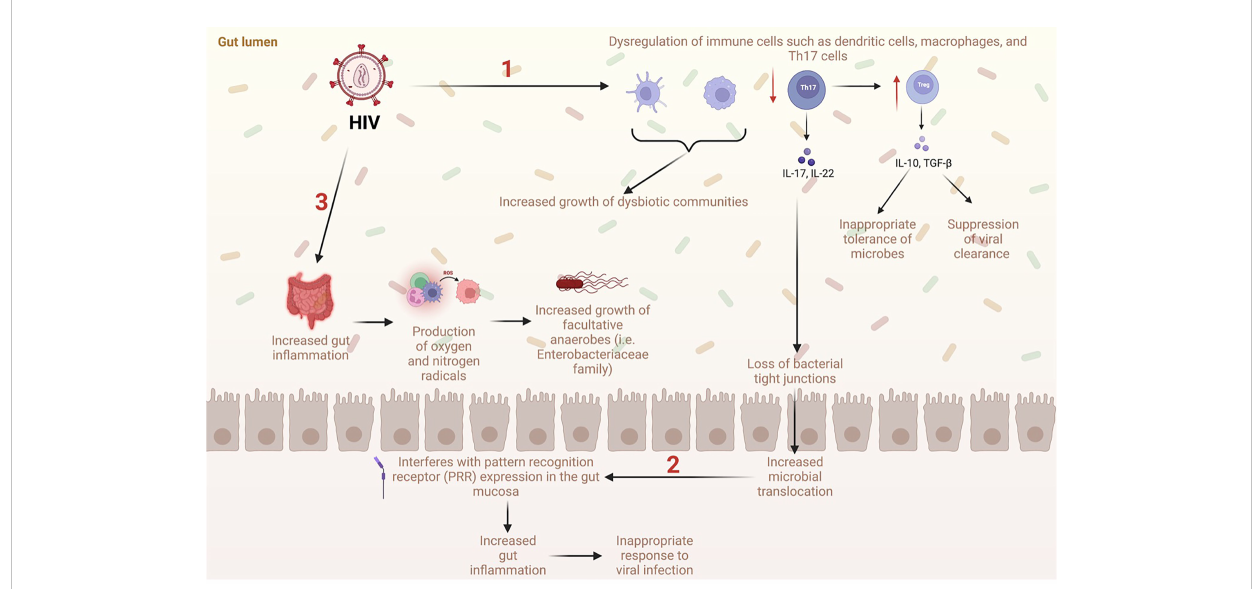
FIGURE 1 Proposed mechanisms of gut dysbiosis and microbial translocation in the GI tract with HIV (1). HIV causes dysregulation of immune cells such as dendritic cells, macrophages, and Th17 cells, which increases the growth of dysbiotic communities. Additionally, HIV causes a signi fi cant decrease in Th17 cells, a subtype of CD4+ T cells, which normally limit microbial translocation. Loss of Th17 cells leads to a decrease in tight junctions in the intestinal epithelium allowing microbes to travel freely between the lumen and systemic circulation. Loss of Th17 cells also causes an increase in Treg cells, which are associated with suppression of viral clearance and inappropriate tolerance of microbes. (2) Increased translocation of microbes into systemic circulation interferes with expression of the pattern recognition receptor (PRR) which ultimately increases gut in fl ammation, decreases immune response to viral infection, and increases growth of dysbiotic communities. (3) Increased gut in fl ammation from HIV infection leads to increased production of oxygen and nitrogen radicals. This is associated with increased growth of facultative anaerobes such as Enterobacteriaceae